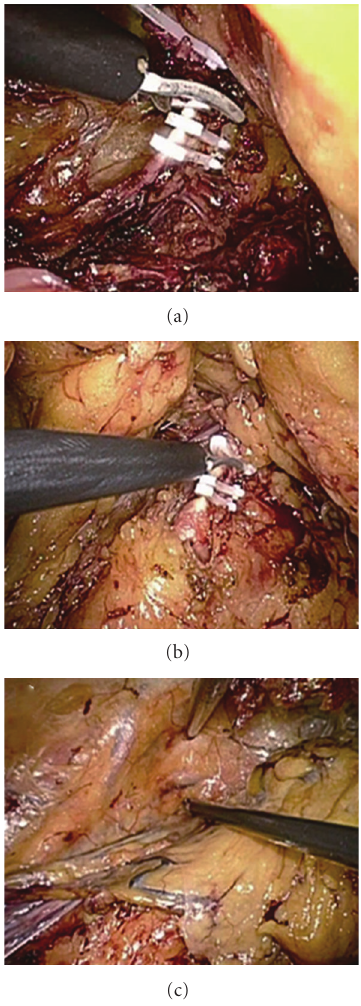
Figure 3: Intraoperative view after renal hilus dissection. (a) Renal artery was divided with Hem-O-Lok clips. (b) The renal vein was clipped with Hem-O-Lok clips. (c) Dissection of the inferior pole of the kidney from the undersurface of the peritoneum in a satisfactory degree of